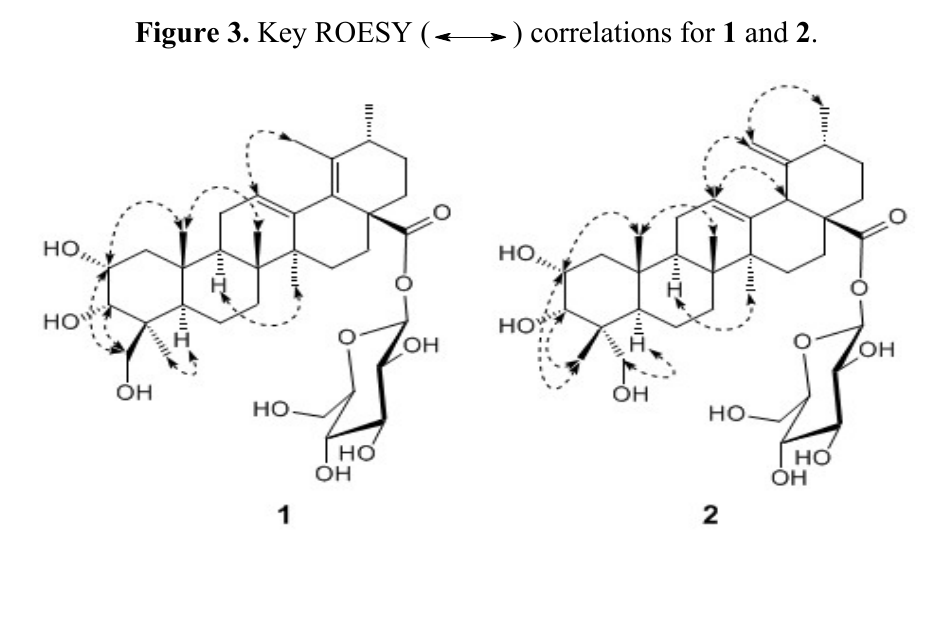
Figure 3. Key ROESY ( ) correlations for 1 and 2